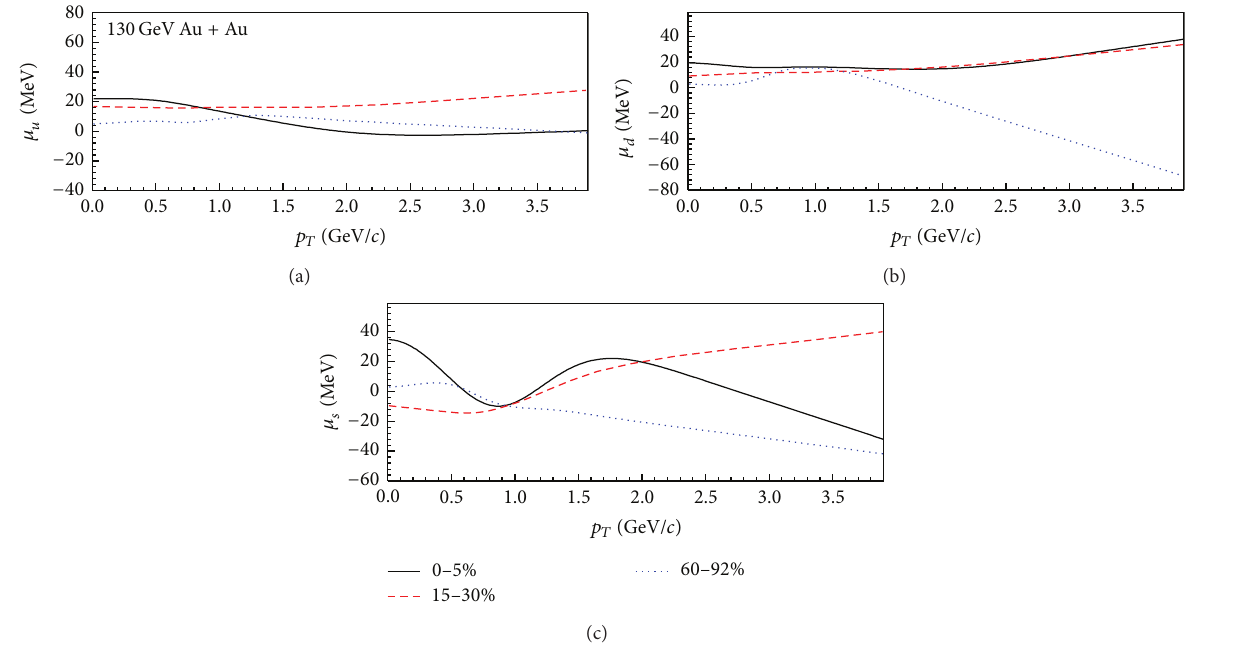
Figure 5: Correlations between chemical potentials of quarks and the transverse momentum in Au-Au collisions at √𝑠 𝑁𝑁 = 130 GeV with different centrality classes. The curves are our results calculated by (4).